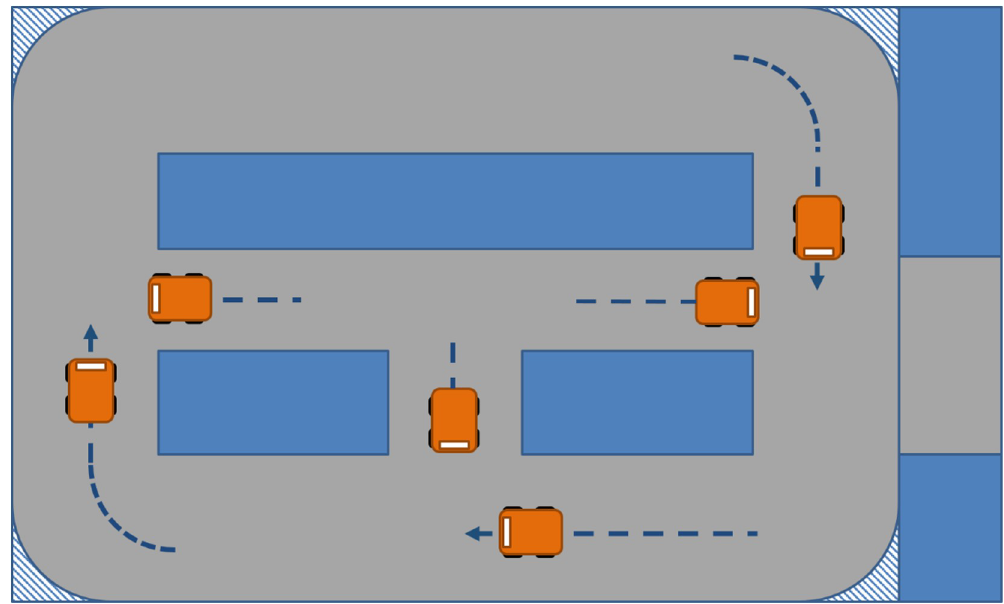
Figure 2. Diagram of the arena showing the interactions at the three T-junctions, where the vehicle going straight had priority.